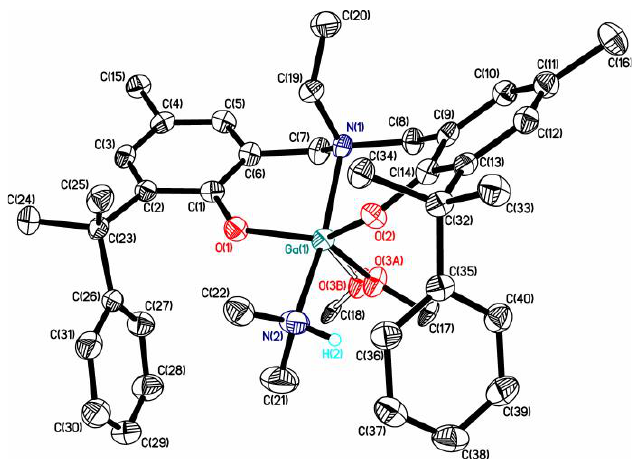
Figure 1. Molecular structure of 7 . Hydrogen atoms (except hydrogen atom on N(2)) and solvate molecule of toluene omitted for clarity. Selected bond Lengths (Å) and angles (deg) for 7 : Ga(1)-